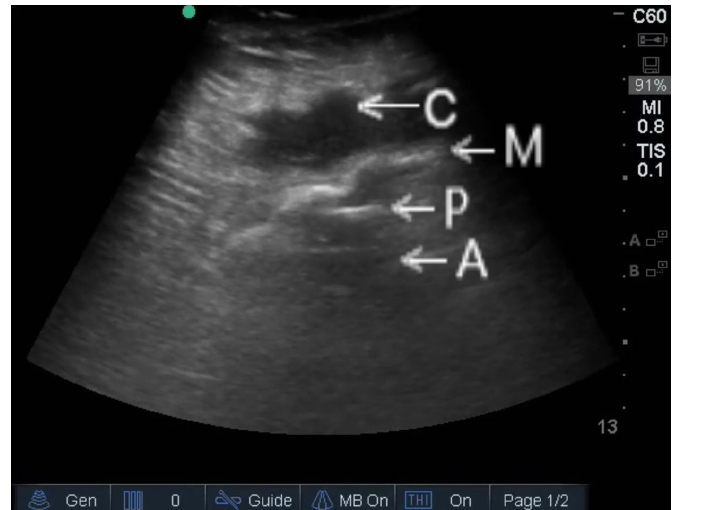
Image 1. Point-of-care ultrasound of the abdominal wall abscess, demonstrating surgical mesh (M) and associated fluid collection (C) extending across the peritoneum (P) and communicating with intraperitoneal abscess (A).